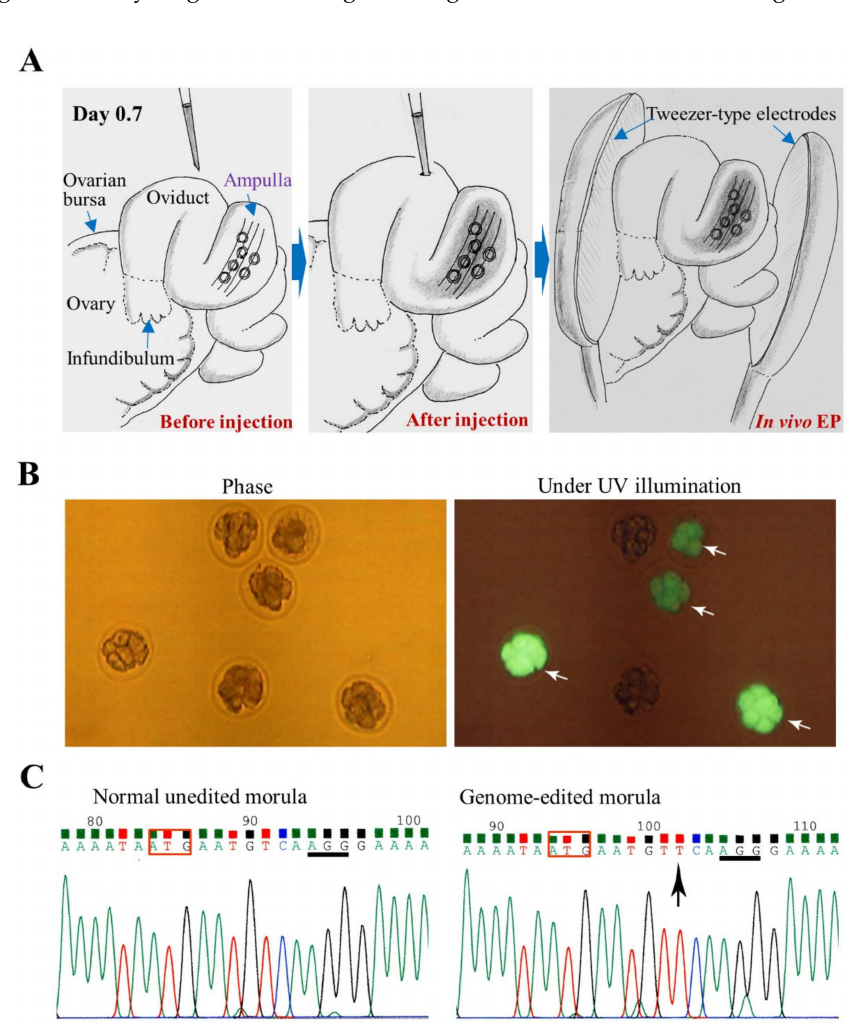
Figure 5. i -GONAD in mice for targeting GGTA1 locus coding for α -1,3-galactosyltransferase, an enzyme capable of synthesizing cell-surface α -Gal epitope: ( A ) Schematic illustration of the i